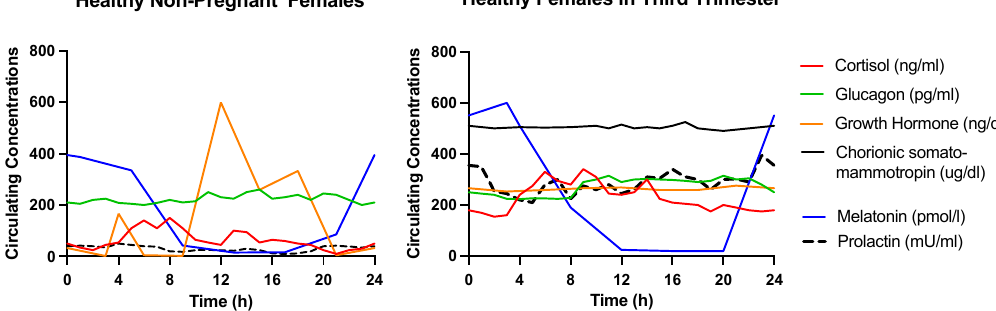
Figure 2. Circulating concentrations of glucoregulatory hormones in non-pregnant healthy females and healthy pregnant females during the third trimester. The data reported in references [32–36] were compiled to create this figure.